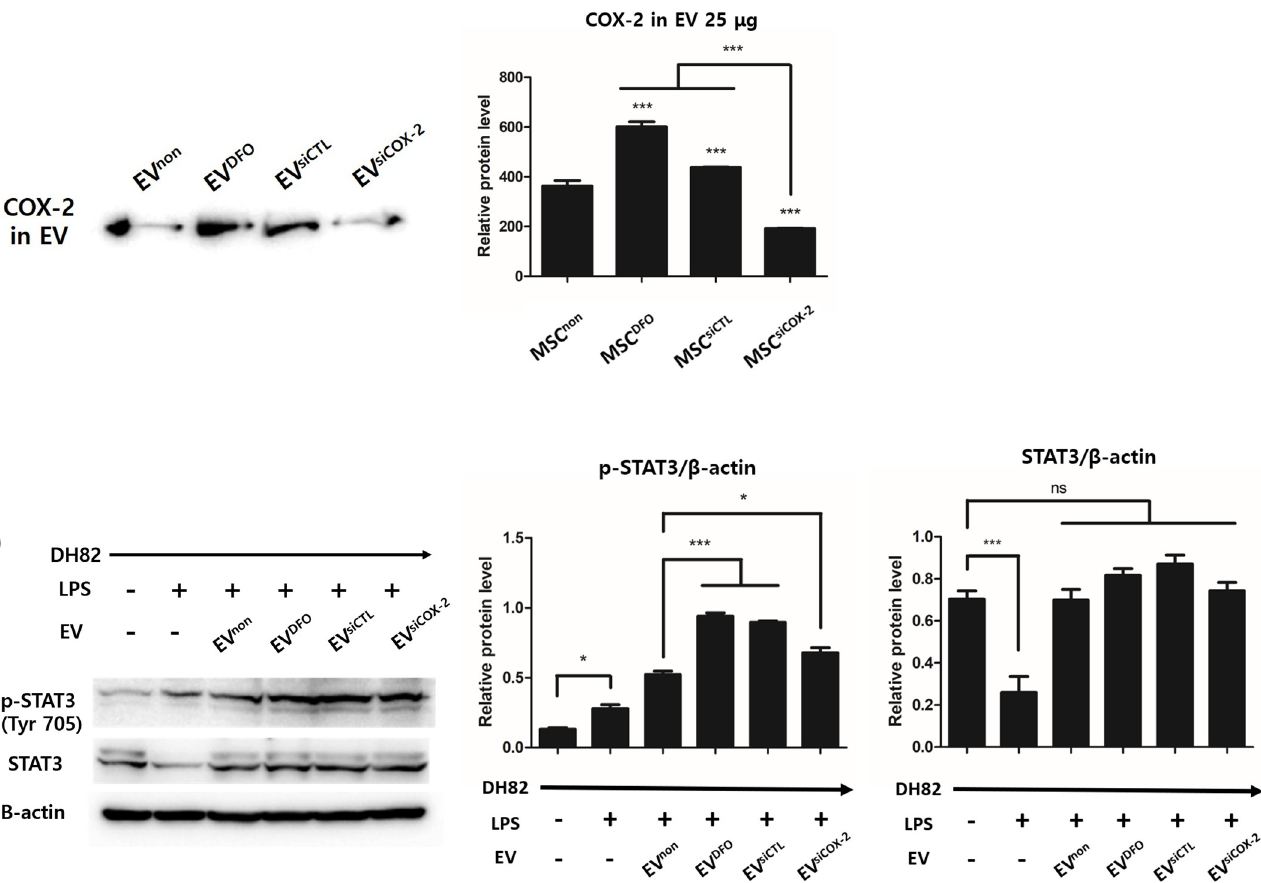
Fig 3. Protein levels of COX-2 in cAT-MSC derived EVs and the effect of DFO preconditioned EV in DH82. (a) COX-2 level was increased in EVs derived from cAT-MSC DFO (EV DFO ). Otherwise, COX-2 was decreased in EV siCOX-2 . The result of COX-2 protein level in EVs was similar with cytosol COV-2 protein level in cAT-MSC. (b) Protein levels of STAT3 and p-STAT3 in DH82 treated with EVs was measured by western blotting to evaluate the effect of DFO preconditioned EVs. In the all EV treated groups, p-STAT3 (Tyr 705) was increased. Compared to EV non treated group, p-STAT3 is much more increased in EV DFO treated group, but similar in EV siCOX-2 treated group. Results are shown as means ± standard deviation. � P < 0.05, ��� P < 0.001. ns, not significant.